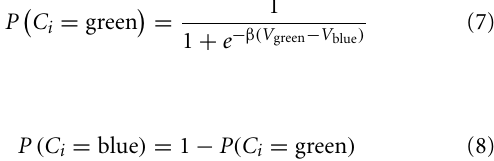
FIGURE 2 | Graphical depiction of the γ parameter in the model. (See equations 1 and 2, section Mathematical model description, for algebraic description). (A) Example transform between objective (RL model-derived) probability and subjective probability, parameterized by γ . As γ increases, small differences in the “objective” probability (tracked by the model) are amplified to have a greater influence on subject behavior. (B) Posterior probability of choosing green for varying levels of